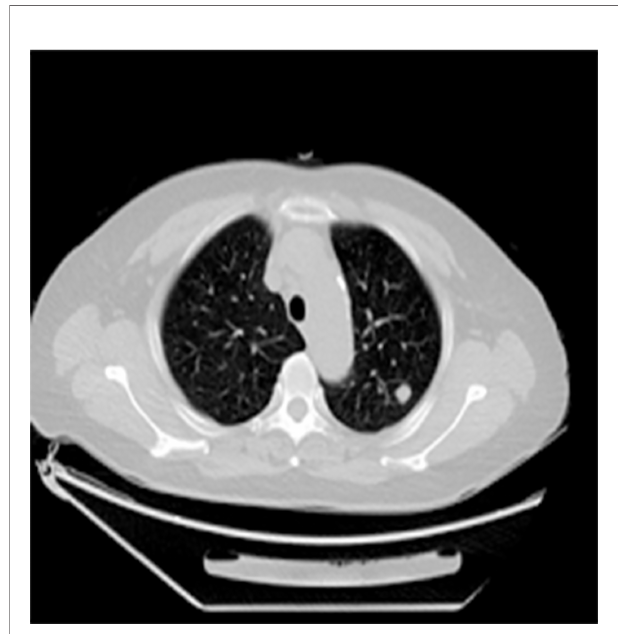
FIGURE 4 | Chest CT showed that a soft tissue nodule in the left upper lobe with lobulated contours, inhomogeneous density, and calci fi cations is visible inside, and the largest cross-sectional dimension of the mass was 1.0 cm × 1.1